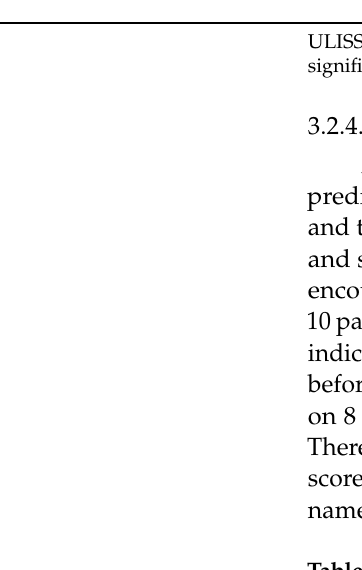
Table 10. Risk of dengue in the village scores, list of stakeholders, larval indices (BI, HI, and CI) before and after